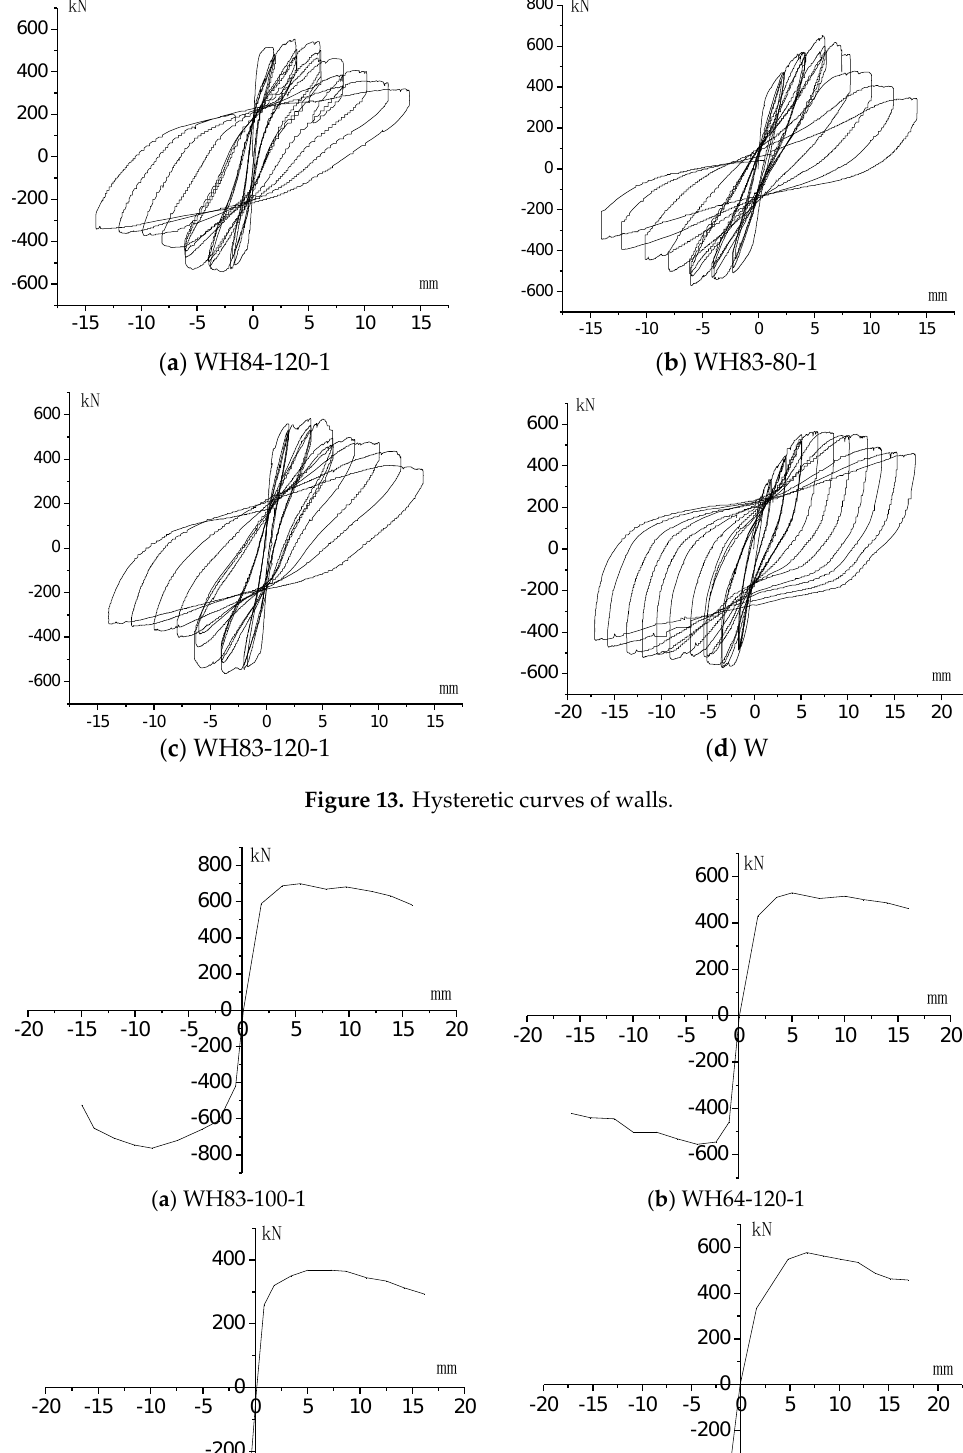
Figure 14. Envelope curves of walls. Do not divide Figure 14 in 2 pages